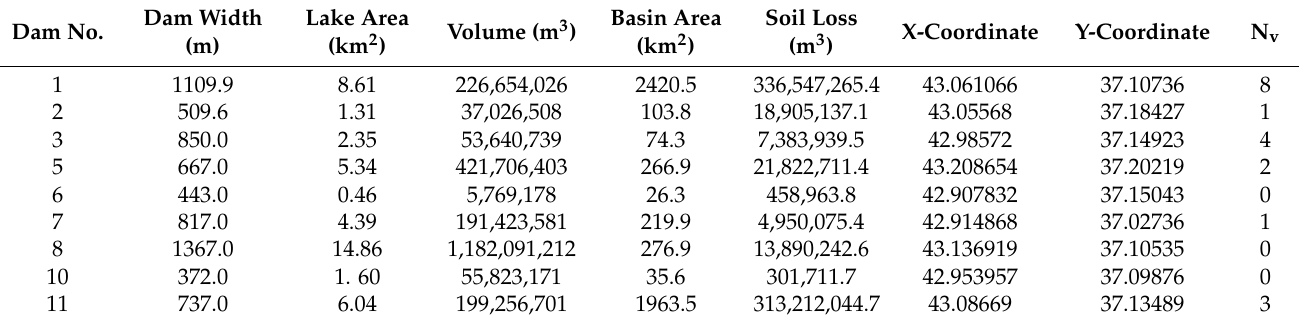
Table 5. Features of the proposed dam (modified after [48]). The dam sites (4 and 9) are excluded because they are outside of the study area. Dam Dam No.